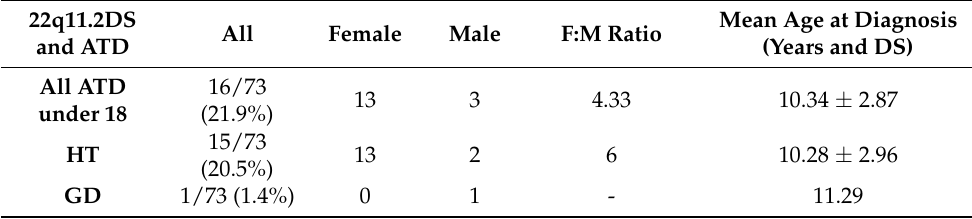
Table 2. General features in patients with 22q11DS and